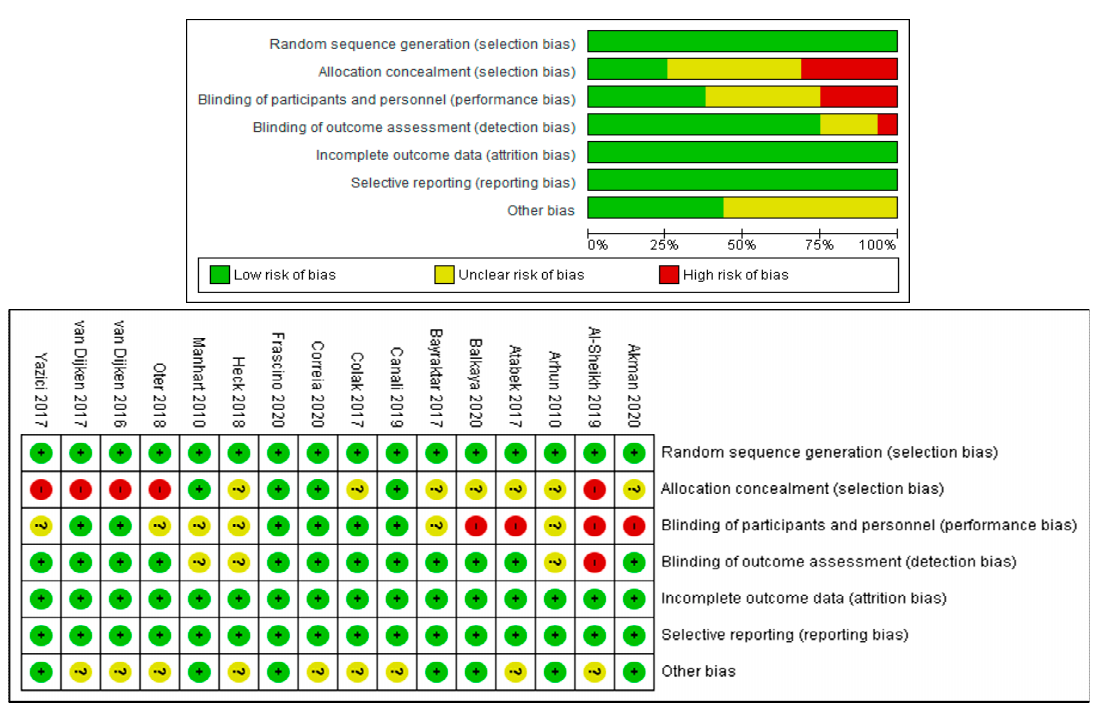
Figure 2. Risk of bias.